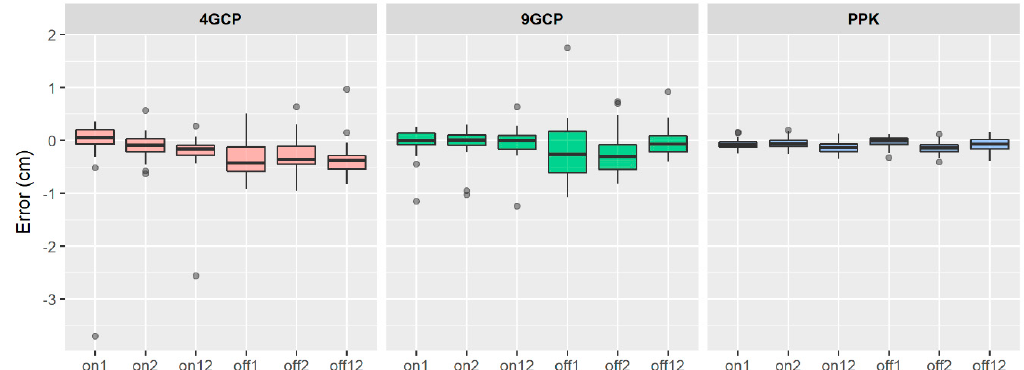
Figure 3. Boxplots represent horizontal errors separated by georeferencing method and divided by the seasons and flight patterns (horizontal line represents median, the lower part of hinge represents the 25th percentile and upper part represent 75th percentile, whiskers represent 1.5 × IQR (interquality range) in both directions) acquired on validation points in Photoscan software.